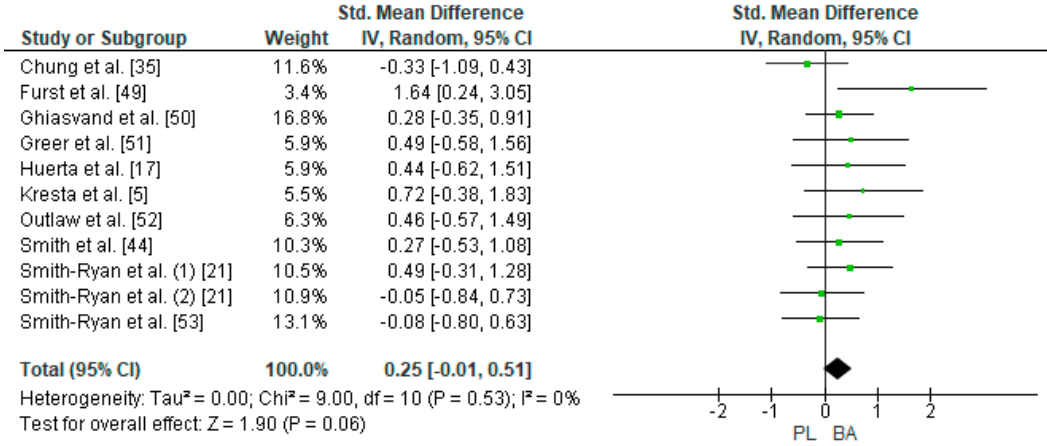
Figure 7. Forest plot comparing the effect of BA on Limited Distance Test. BA: beta ‐ alanine; PL: placebo.